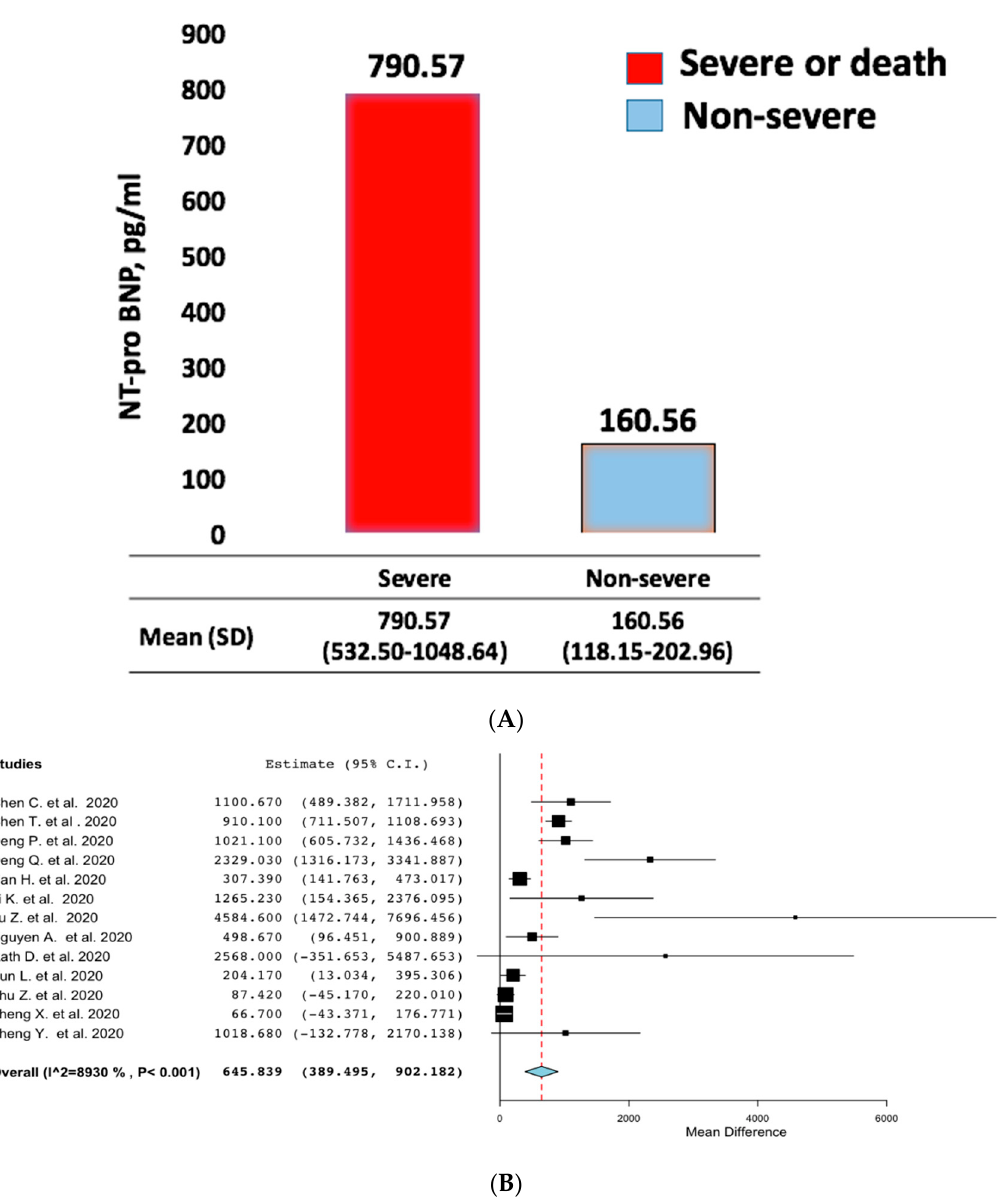
Figure 1. Pooled ( A ) and mean difference ( B ) of N-terminal natriuretic peptide (NT-proBNP) levels in severe or death and non-severe patients.